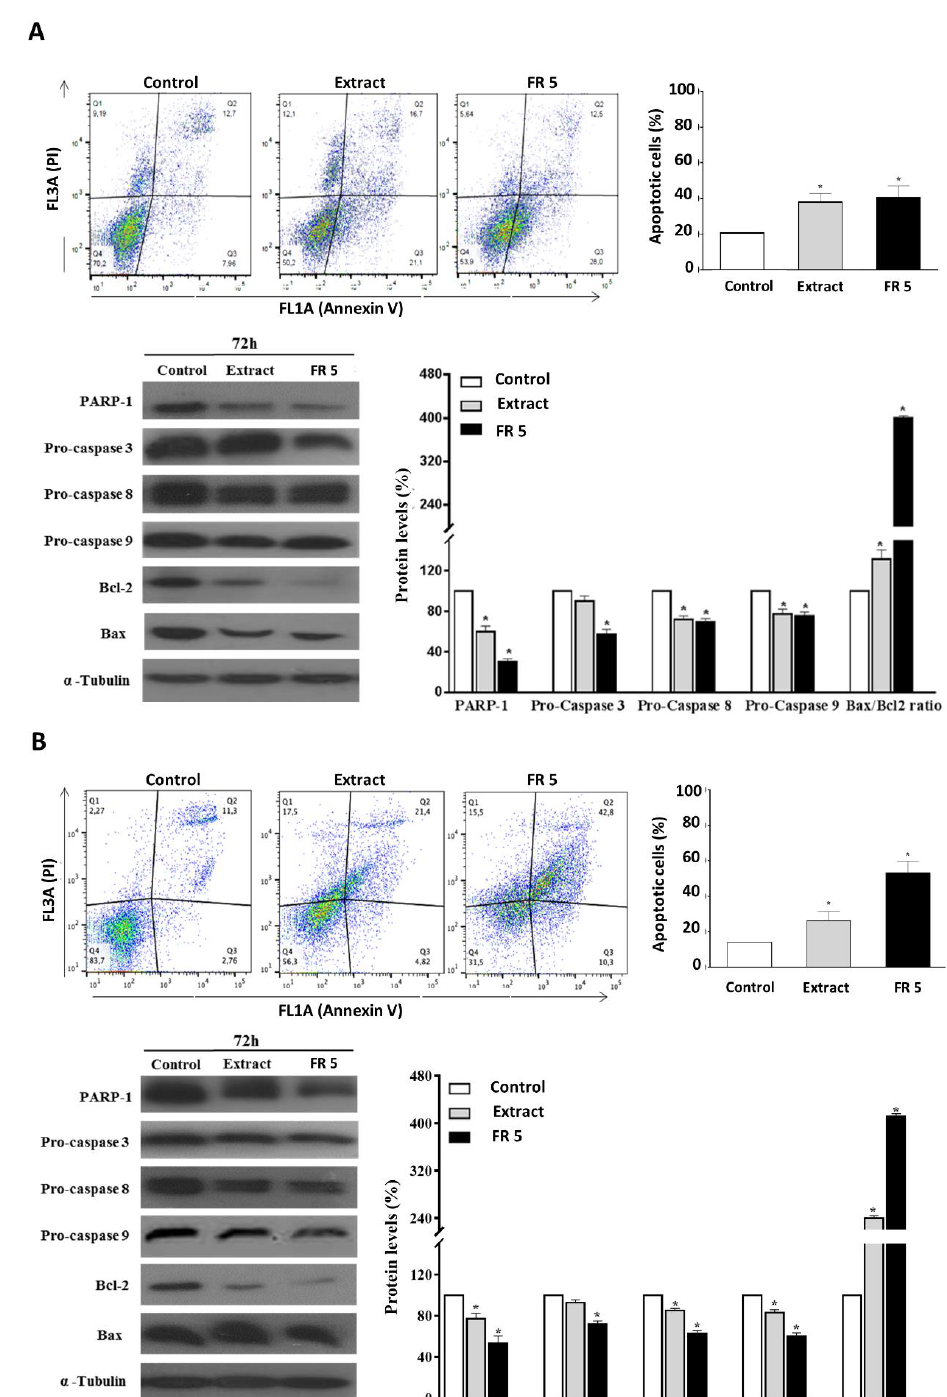
Figure 6. Effect of grape cane extract obtained at pH 7 for 60 min and its polyphenol-rich FR 5 on apoptosis in HNSCC cells. Cal-33 ( A ) and JHU-SCC-011 ( B ) cells were treated for 72 h with 0.25 mg/mL of grape cane extract and 0.10 mg/mL and 0.12 mg/mL of polyphenol-rich FR 5, respectively, and the apoptotic process was evaluated by FACS analysis. The different quadrants reported in the representative dot plots of both Annexin V-FITC and PI-stained cells show the percentage of cells: viable cells, lower left (Q4); early apoptotic cells, bottom right (Q3); late apoptotic cells, top right (Q2); nonviable necrotic cells, upper left (Q1). For each sample, 2 × 10 4 events